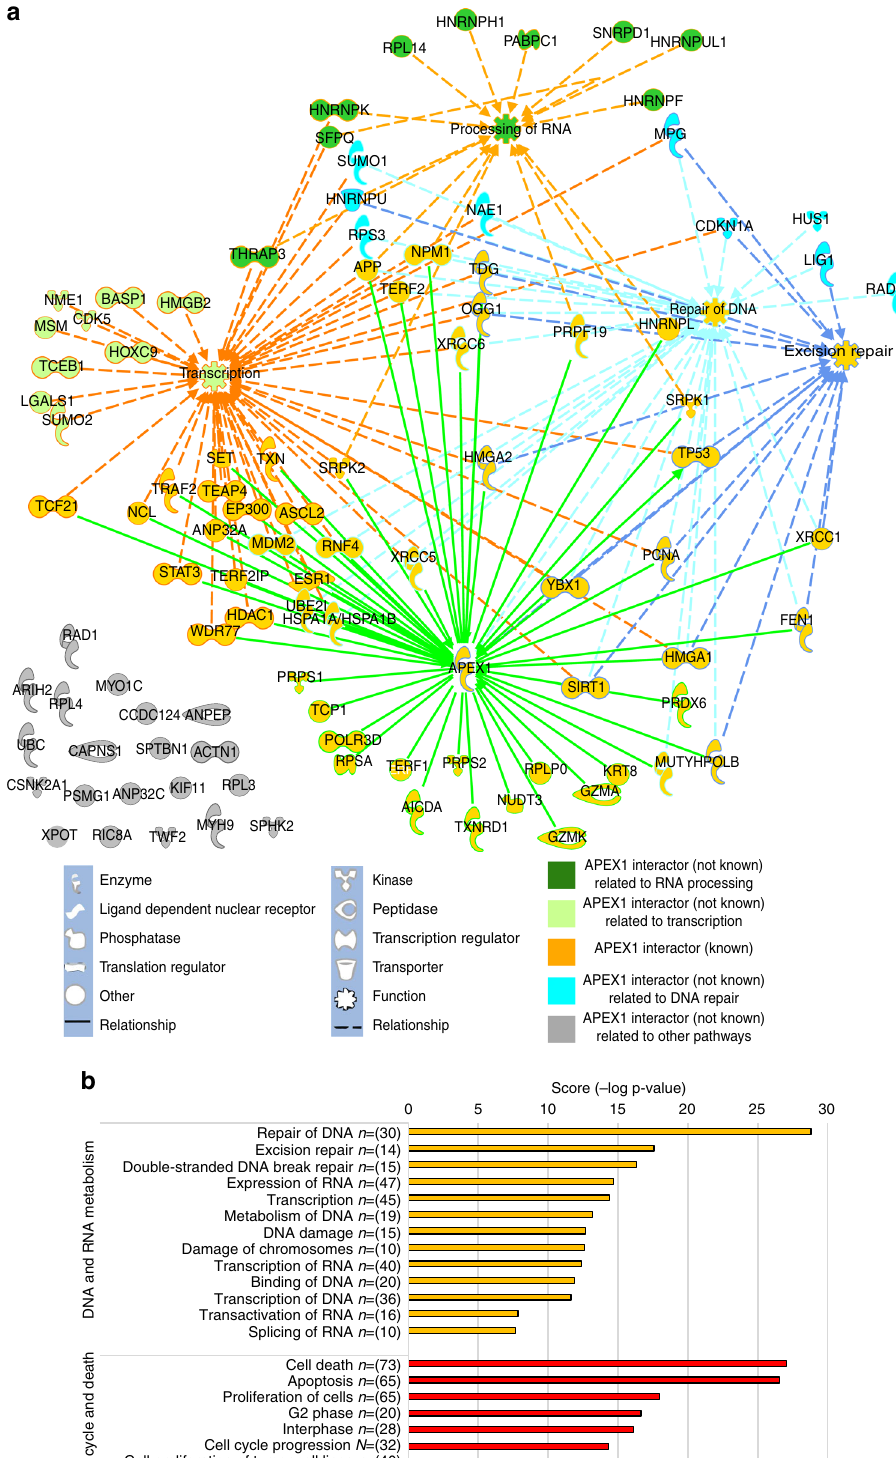
Fig. 7 APE1 – protein interactome network. a Protein network generated by Ingenuity Pathway Analysis. Starting from the gene list of the APE1-interacting protein partners, an interaction network was generated using the “ connect tool ” in order to differentiate between known or novel partners, also taking advantage of the Ingenuity Knowledge base. By using the “ annotation tool ” , we selected and connected in the network the top four functional themes that were able to annotate the majority of the genes (63%). In the legend, we show the meaning of the shape representation and the molecular relationships in the IPA network. b Bar chart showing the enrichment of speci fi c functions obtained using IPA for the APE1-binding protein partners. Bars length represent the – (log P -value) of the